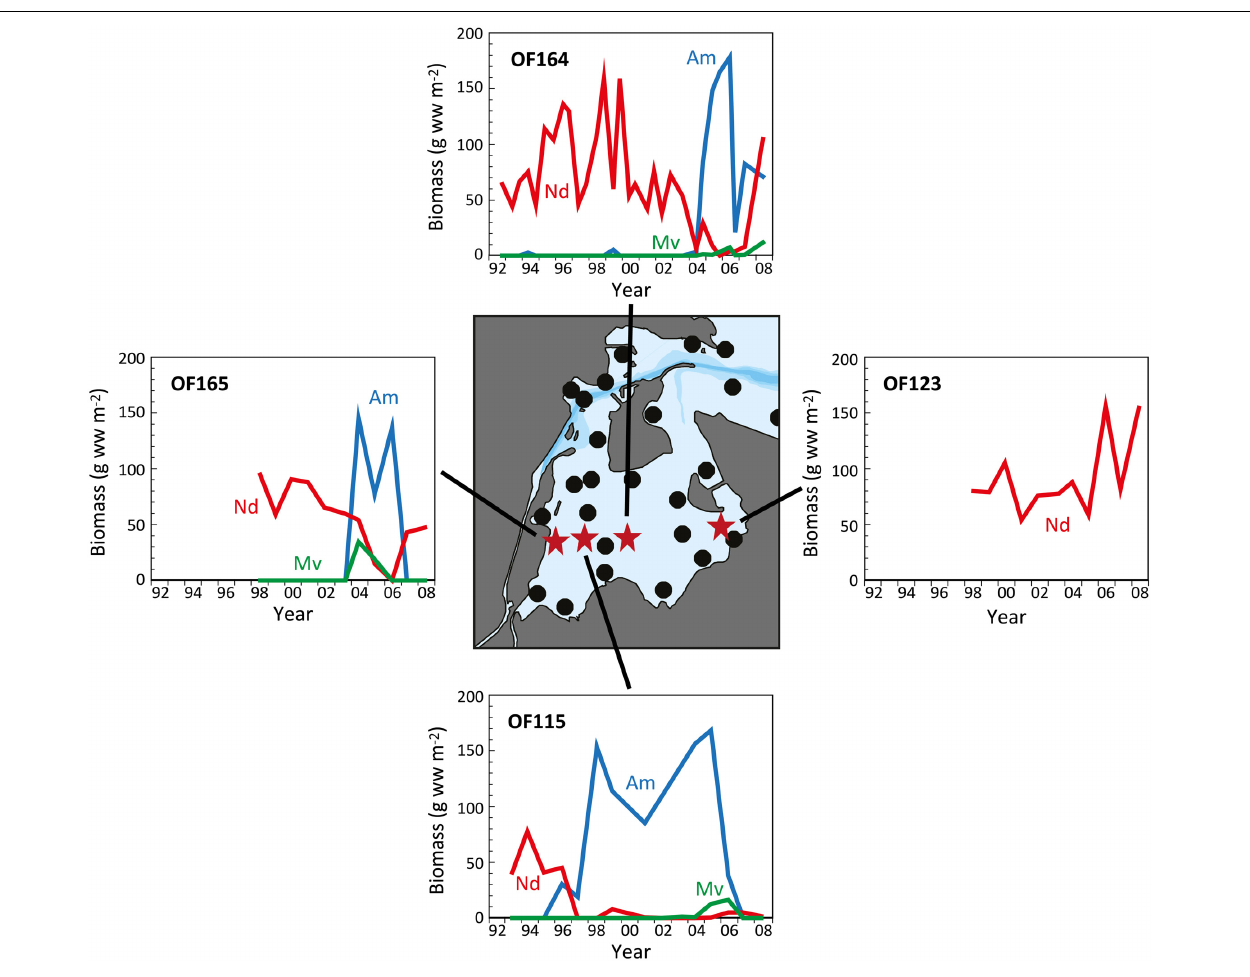
FIGURE 5 | The temporal development in biomass of Nereis diversicolor (Nd), Arenicola marina (Am), and Marenzelleria viridis (Mv) at 4 representative stations (OF115 from 1993 to 2008; OF123 from 1998 to 2008; OF164 from 1992 to 2008; and OF165 from